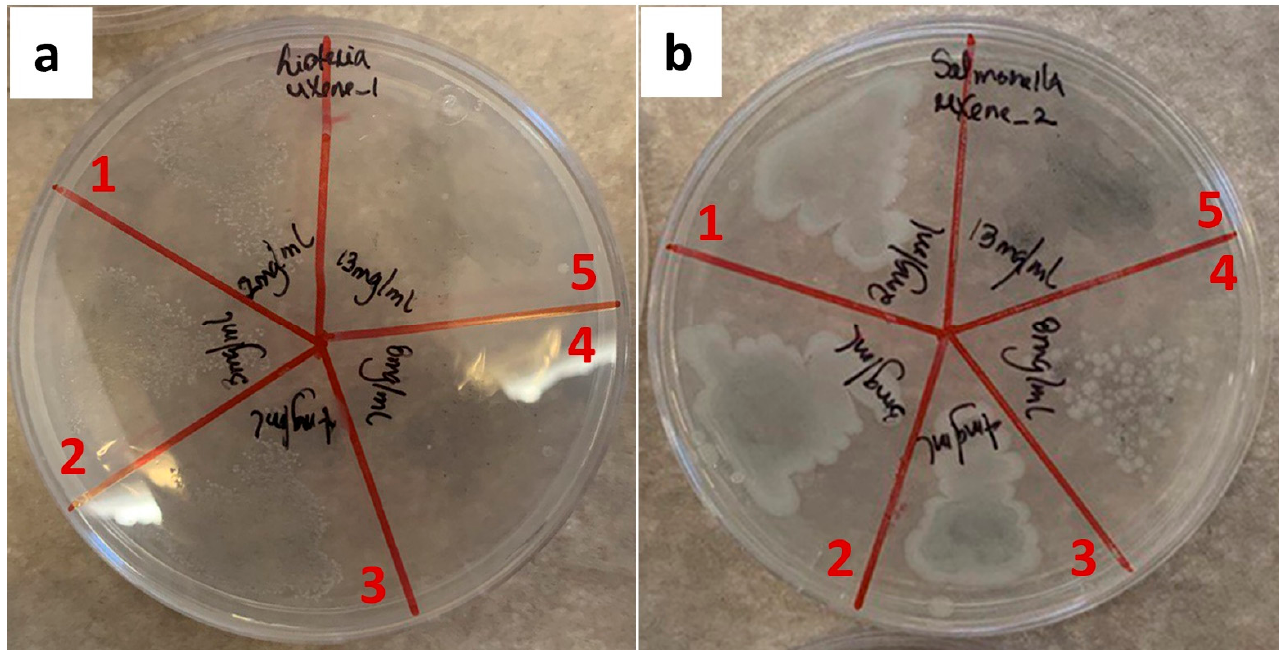
Figure 2 . The minimum bactericidal concentration of MXene against ( a ) L. monocytogenes ; ( b ) S. en- terica . Red numbers correspond to the different tested concentrations as it follows: 1 corresponds to 2 mg/mL, 2 to 3 mg/mL, 3 to 4 mg/mL, 4 to 8 mg/mL and 5 to 13